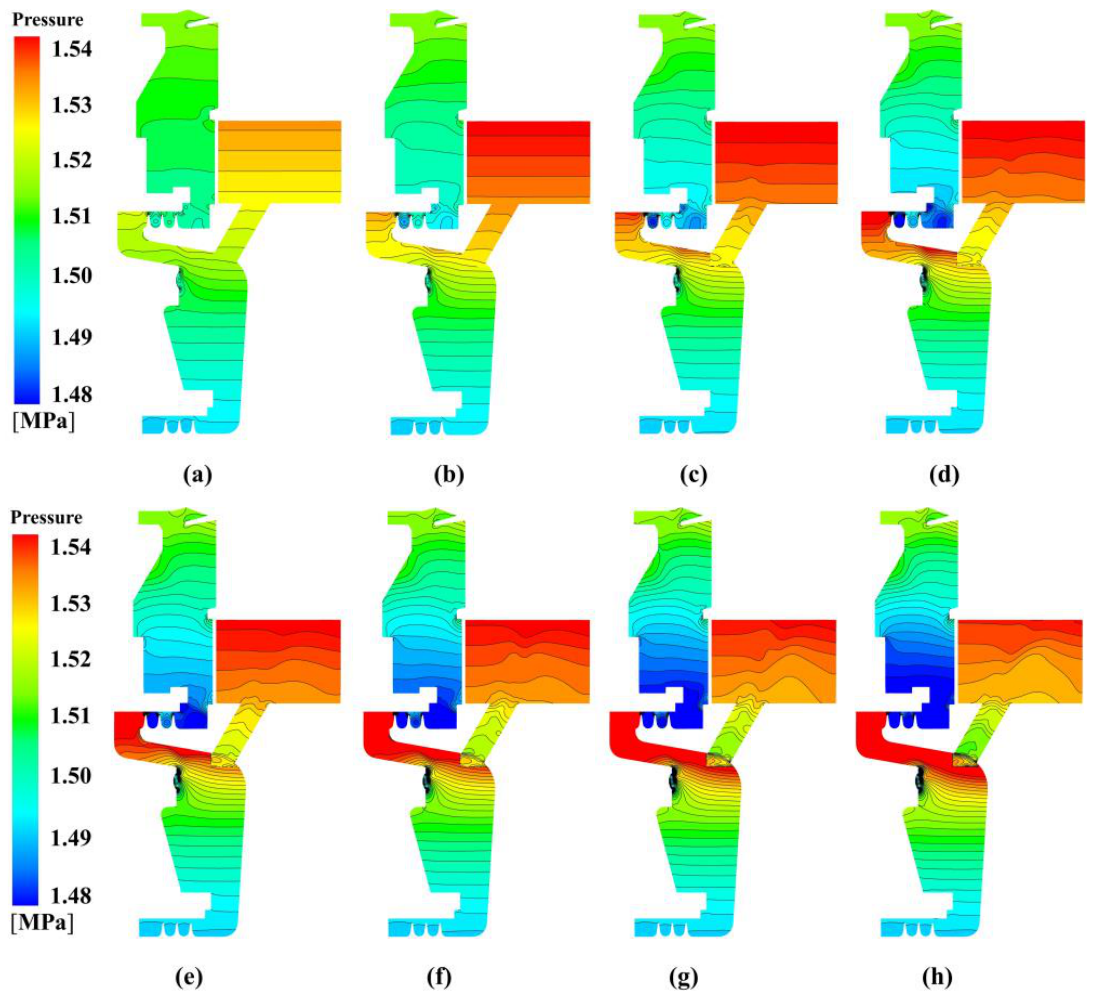
Figure 6. Pressure distribution of pre-swirl cavity at Re = 9.5172 × 10 5 with different nozzle pres-